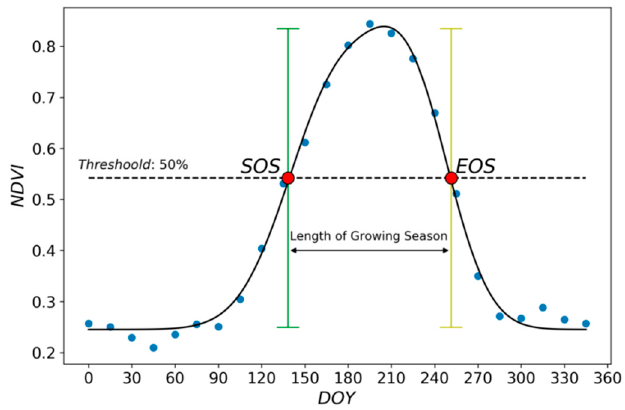
Figure 2. Midpoint method to extract the start of the growing season (SOS) and the end of the growing season (EOS), using the NDVI time series.